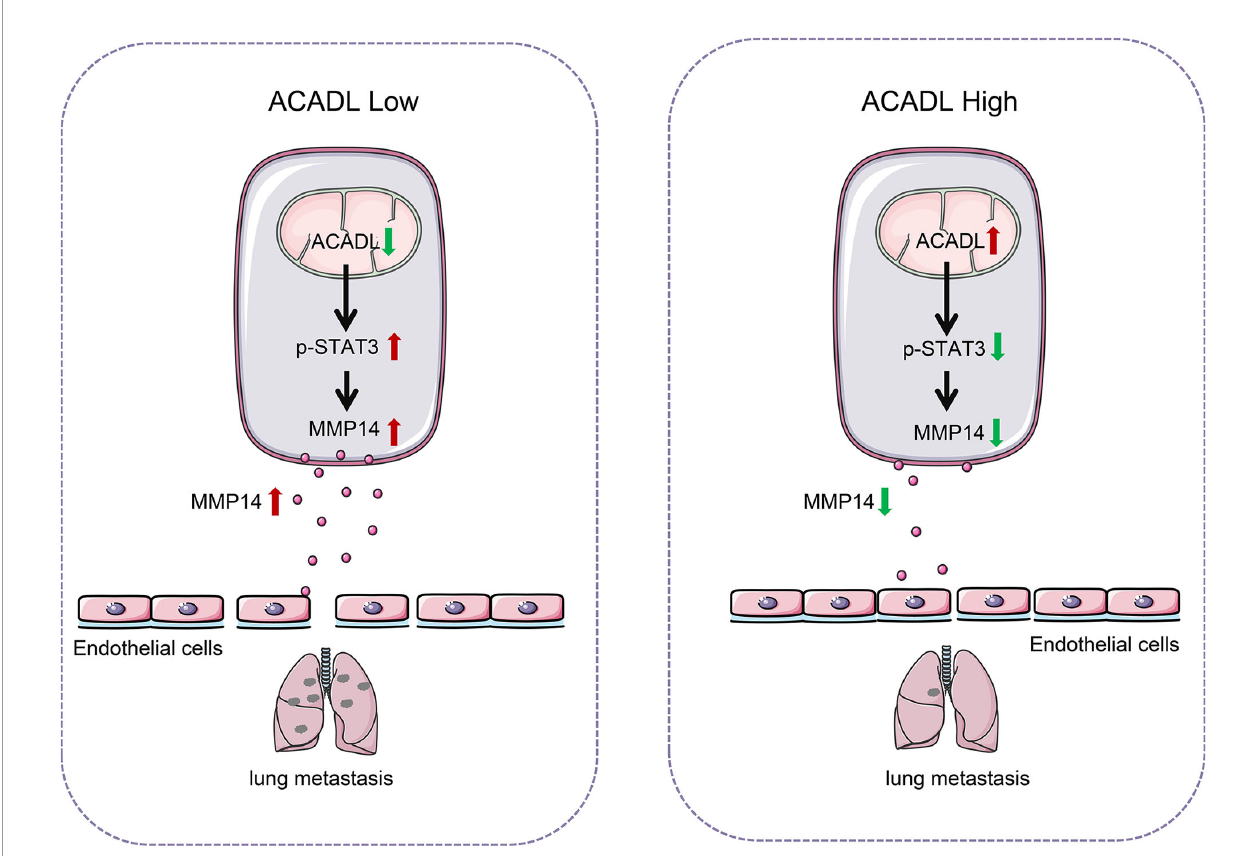
FIGURE 8 | Working model of the study. A schematic diagram of the role of ACADL-STAT3-MMP14 axis in HCC metastasis. ACADL downregulates MMP14 expression by inhibiting STAT3 pathway. ACADL suppresses HCC metastasis and decreases normalized vascular leakiness by inhibiting STAT3 activation and MMP14